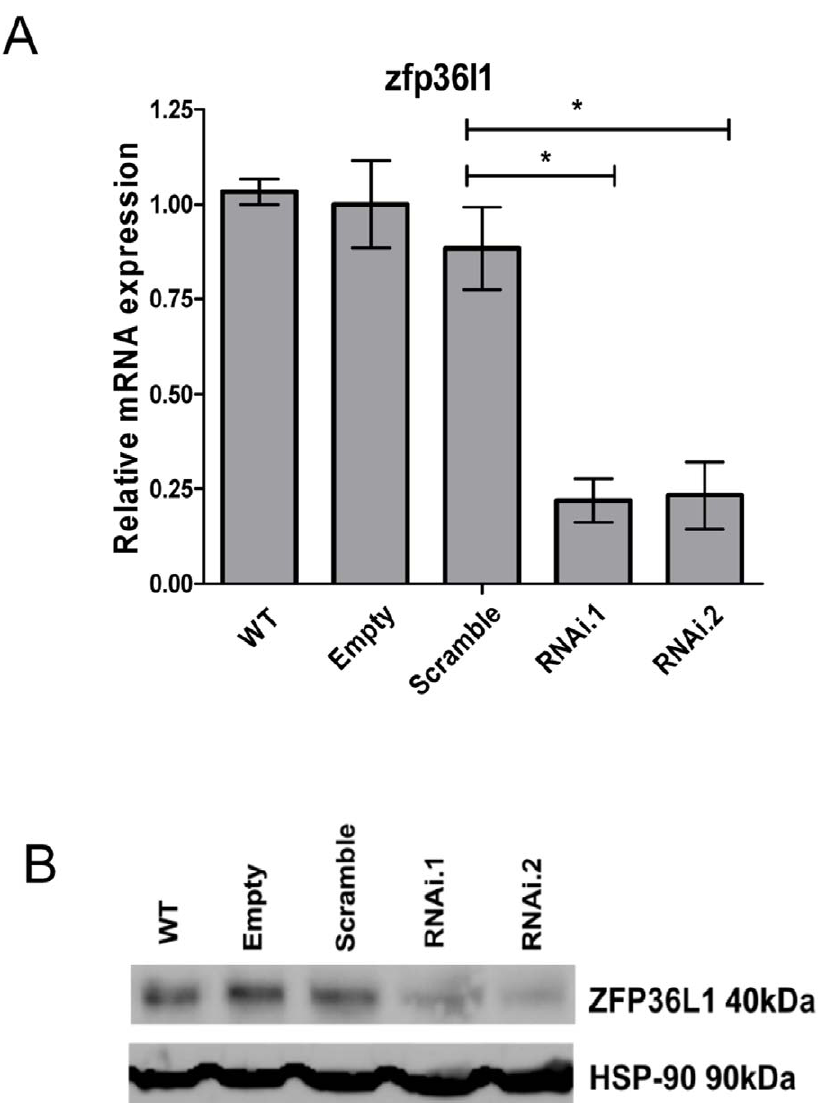
Figure 4. Effective downregulation of zfp36l1 mRNA and protein expression by zfp36l1 shRNA lentivirus (pSicoR.zfp36l1) in independent lentiviral transduced BCL1 cell lines. (A) qRT-PCR analysis of zfp36l1 mRNA levels in pSicoR.zfp36l1.RNAi1 and pSicoR.zfp36l1.RNAi2 lentivirus infected cells compared to wild-type, empty vector or pSicoR.scramble.RNAi infected cells. The results represent mean 6 SD (n=3) of zfp36l1 mRNA levels in three independent cells lines generated by three independent rounds of lentiviral infection for each cell type (apart from wild-type). *=p , 0.05 as determined by t-test. (B) Western blot analysis of ZFP36L1 protein expression in wild-type, empty vector, scramble, pSicoR.scramble.RNAi1and pSicoR.scramble.RNAi2 cells. HSP90 levels are shown as a loading